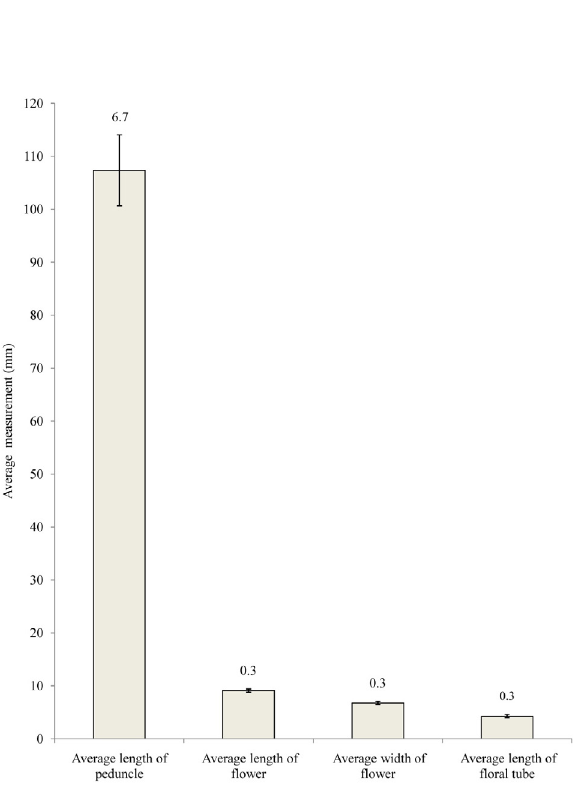
Figure 6: Average measurement of quantitative morphological cha- racters of cinnamon accessions. Error bars represents the standard error of the